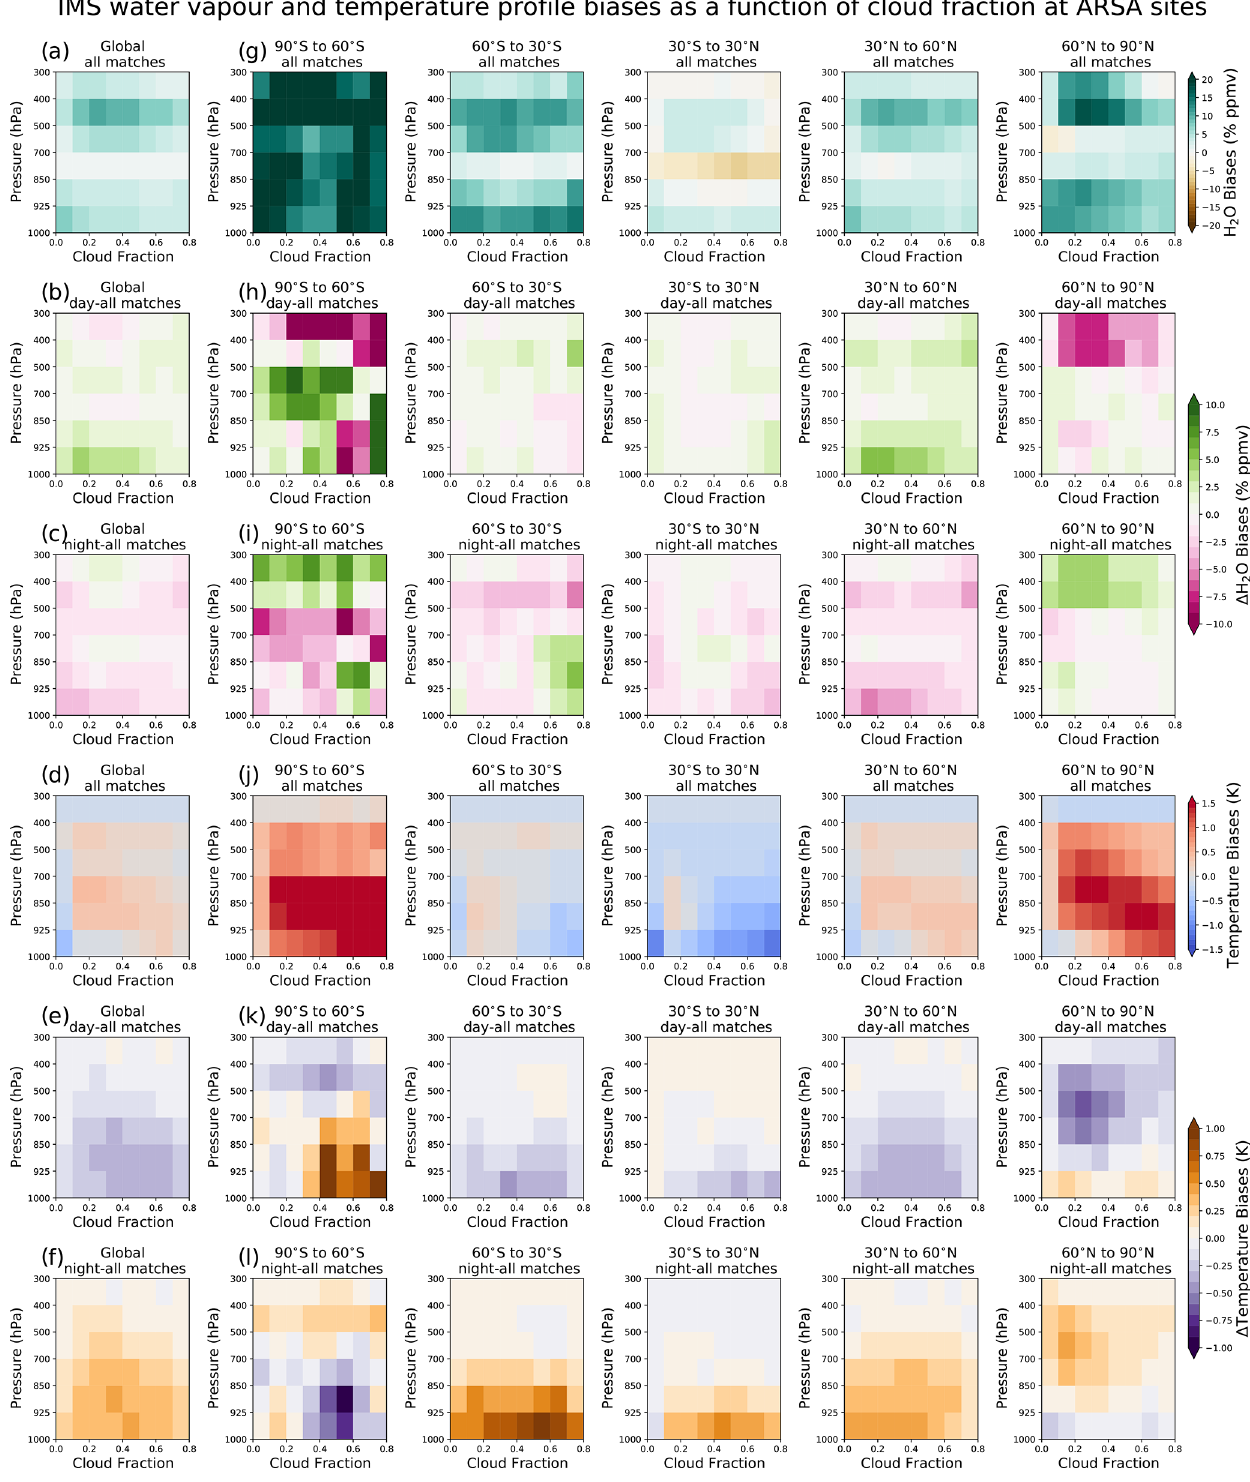
Figure 11. Cloud fraction effects on IMS biases relative to ARSA radiosonde water vapour and temperature profiles. Results here are broken down into global water vapour and temperature biases (a, d) , daytime differences from global biases (b, e) , night-time water vapour and temperature bias differences (c, f) , and biases calculated for five broad latitudinal bands (g, j) , as well as the daytime and night-time differences ( h, i and k, l ,